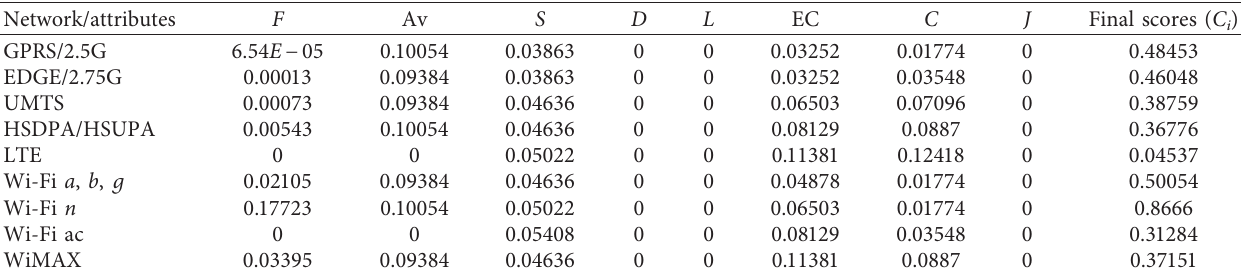
Table 7: The weighted and normalized V matrix and the final scores $C_i$ using